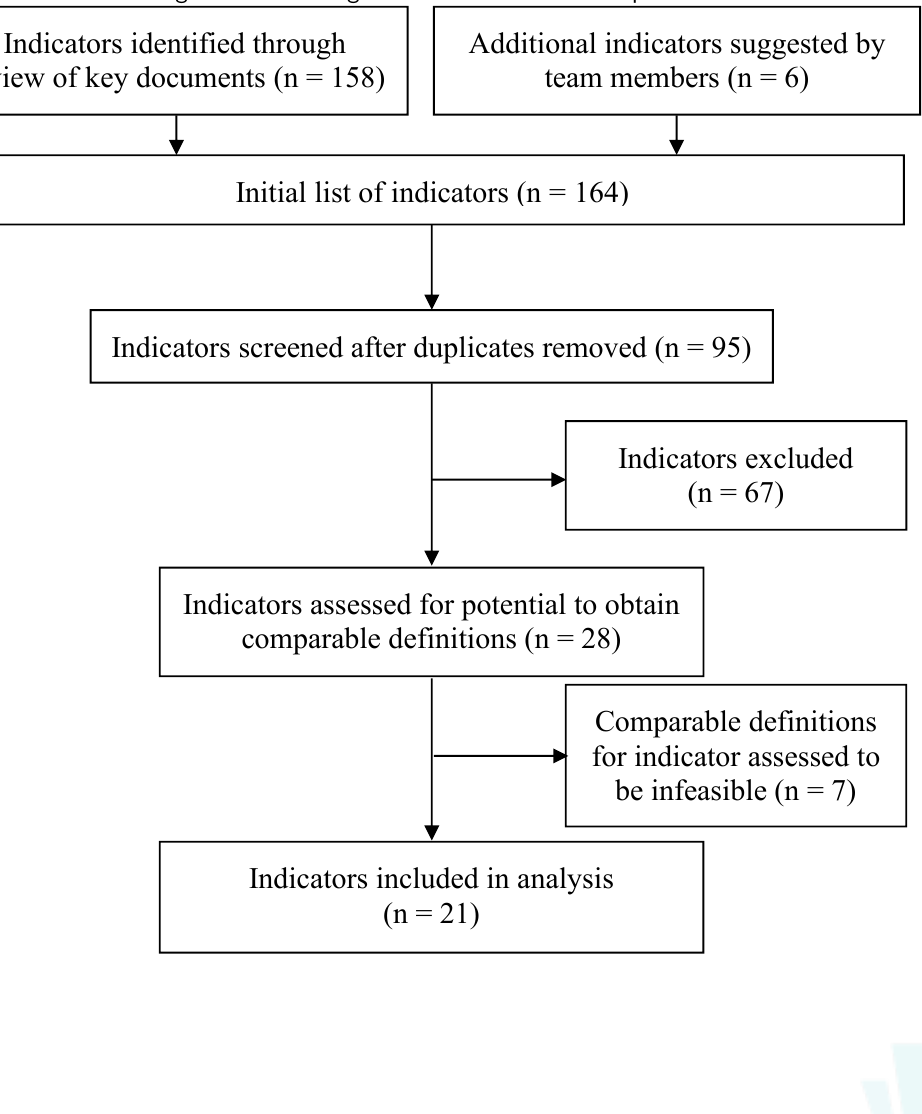
Figure 1: Flow diagram of indicator selection